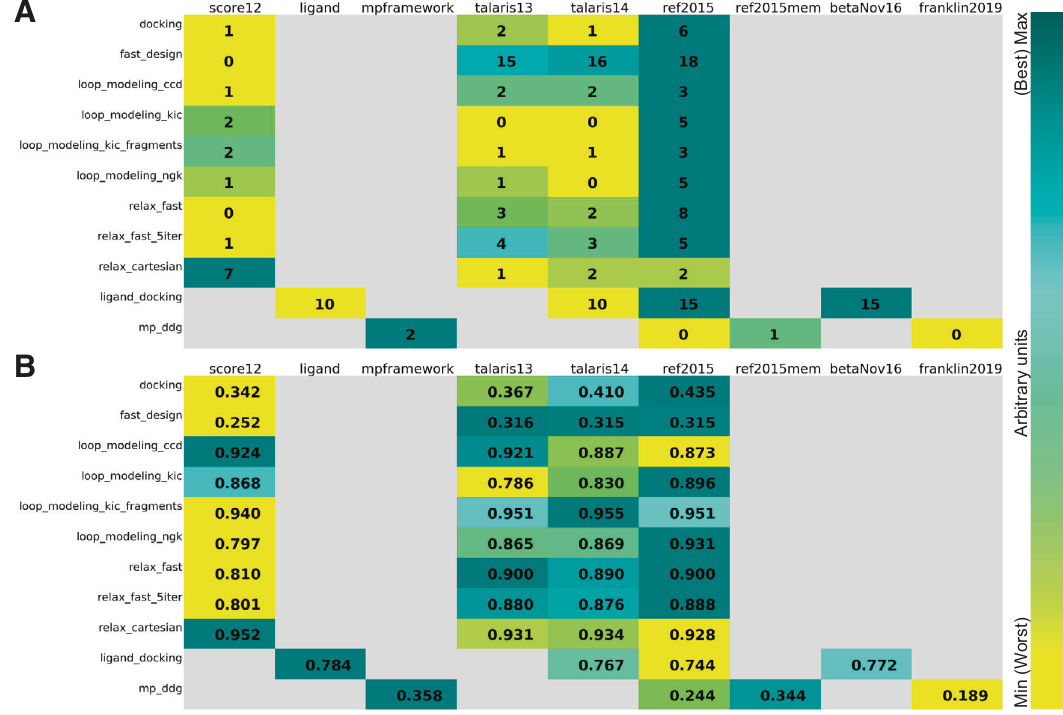
Fig. 5 Summary of score function comparisons. Comparison of different score functions (one per column) for different applications and protocols, using the P Near metric as an indication of “ funnel quality ” . P Near falls between 0 (no funnel or incorrect global minimum) and 1 (the perfect funnel). The lambda parameter indicates the spread on the x -axis and is set to 4.0 in our comparison. Cells are colored according to the color bar on the right, teal is better. Unavailable data is indicated in gray. A The panel uses a “ winner-takes-all ” comparison: for each protein, the score function with the highest (i.e., best) P Near value (see methods) gets a point. Points are then summed by column, identifying the score function with the most and highest proteins, the higher the better. B The averages of the P Near values for each score function were used, i.e., computed over each column. Higher values are better.